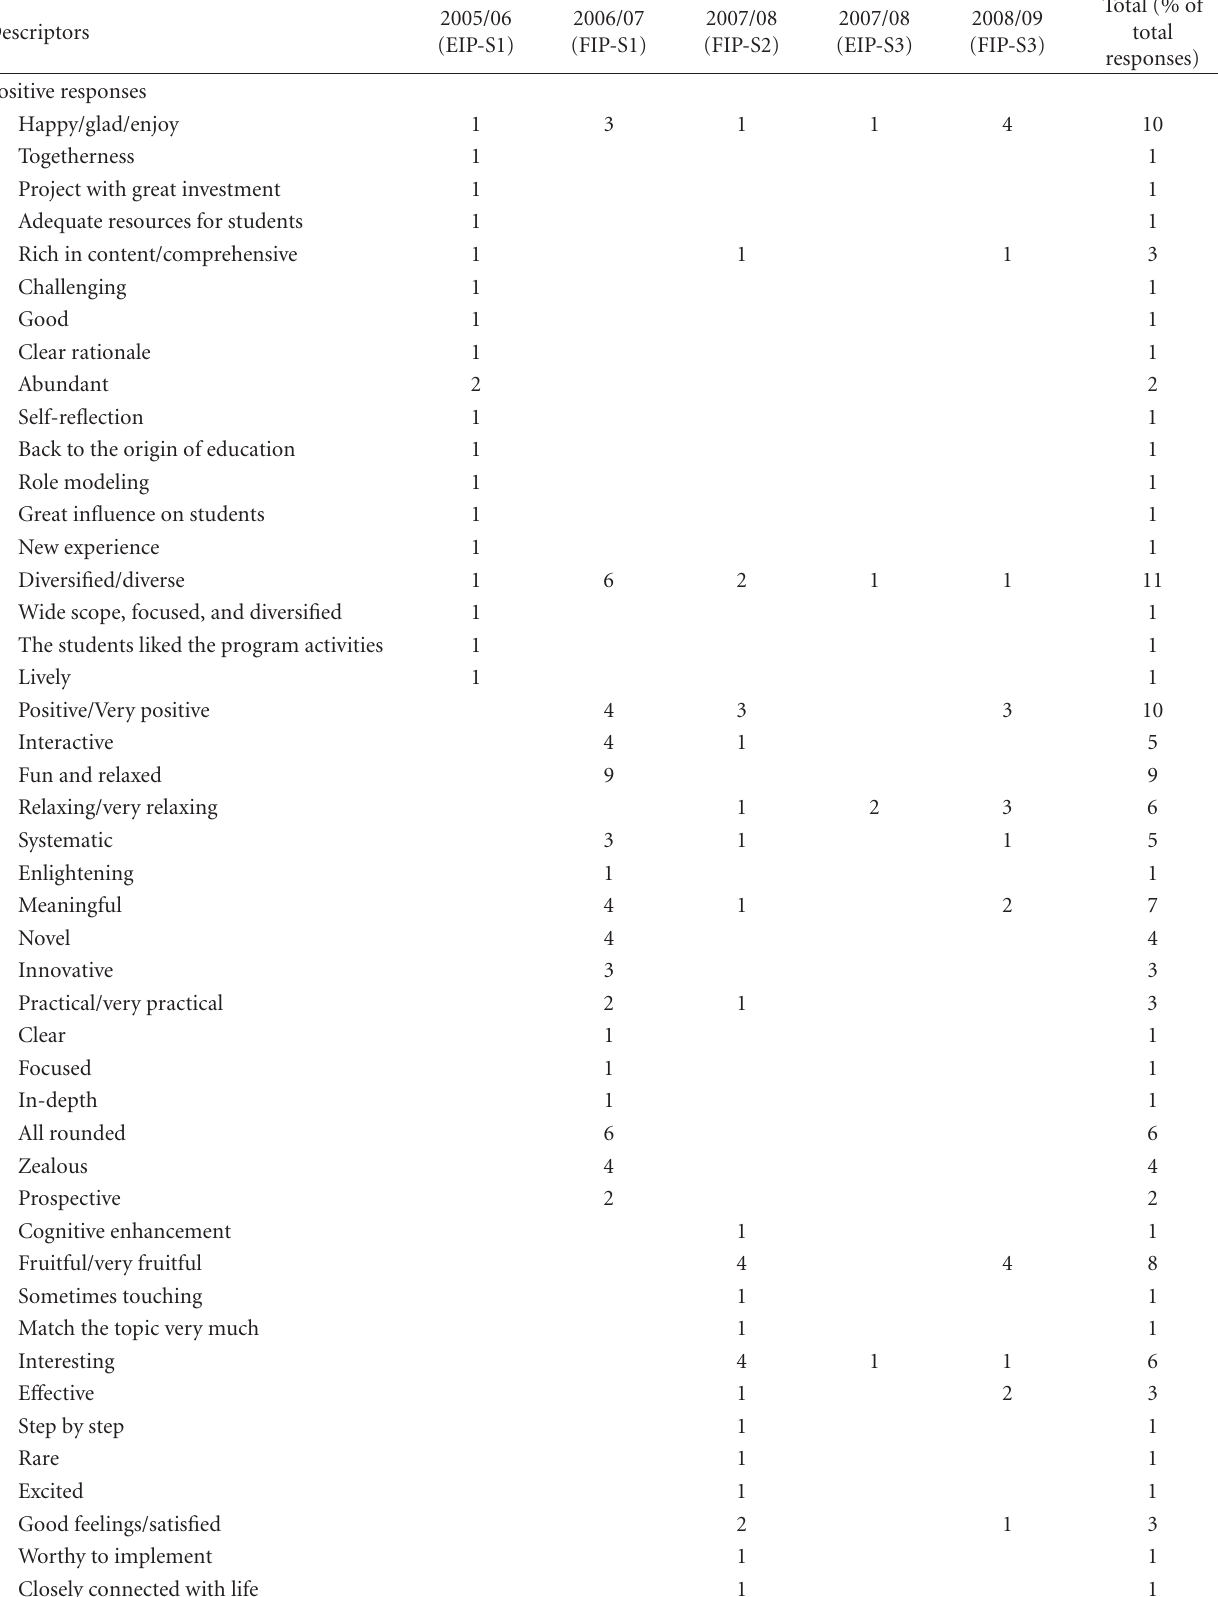
Table 3: Categorization of the descriptors used by the program implementers to describe the program.